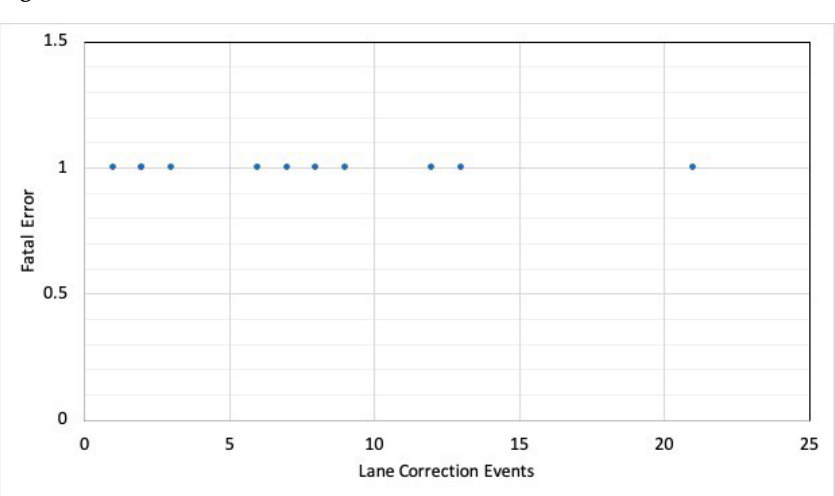
Figure 7. Fatal error vs. lane corrections events for test 6.0.1.